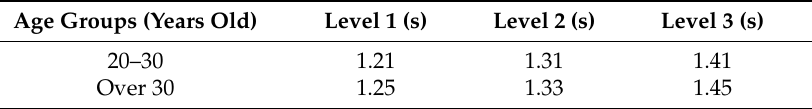
Table 7. The average reaction time of different age groups.